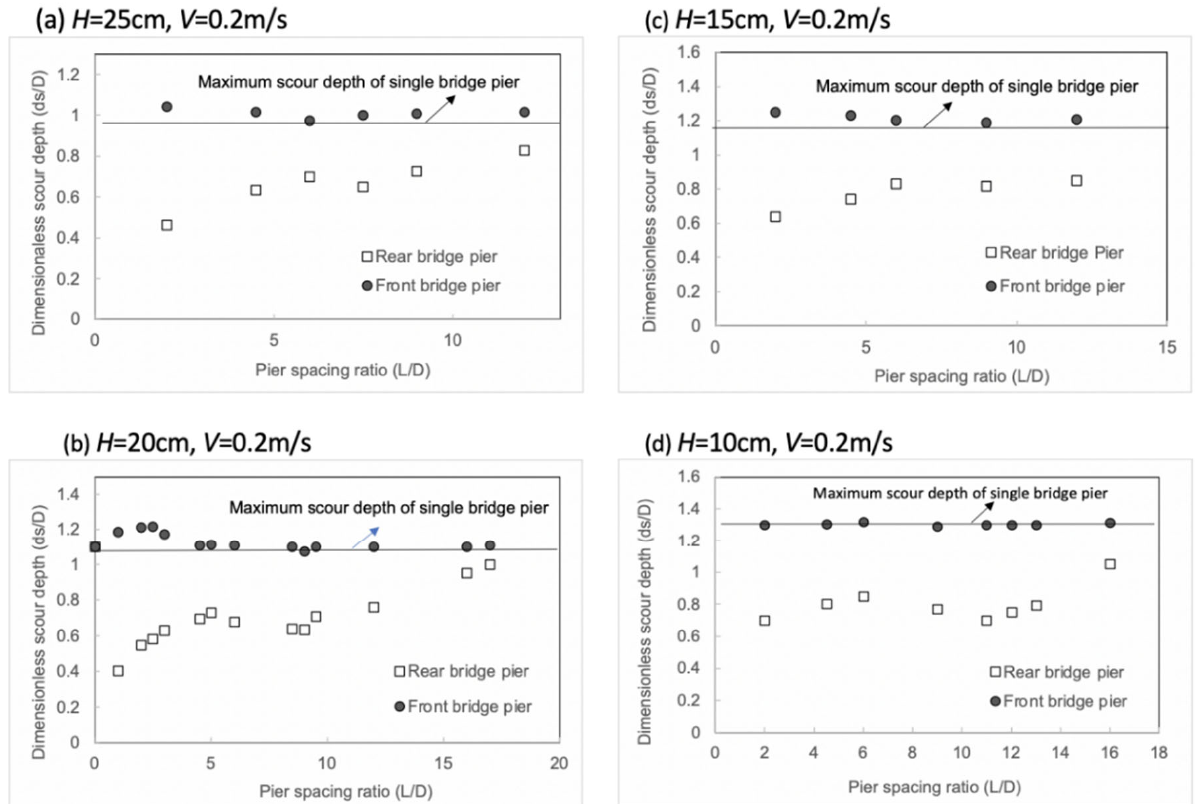
Figure 8. Relationship between scour depth and pier spacing ratio. ( a ) H = 25 cm, V = 0.2 m/s; ( b ) H = 20 cm, V = 0.2m/s; ( c ) H = 15 cm, V = 0.2 m/s; ( d ) H = 10 cm, V = 0.2 m/s).